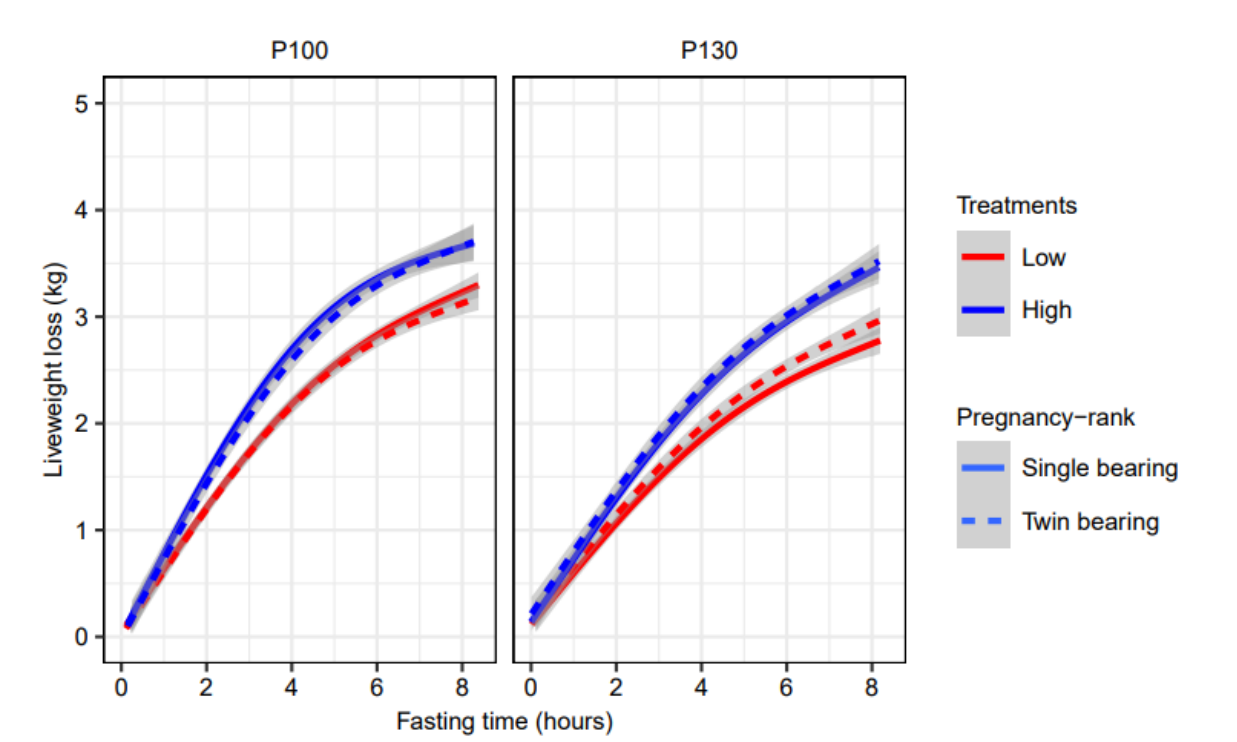
Figure 2. Change in liveweight (with 95% CI, grey shade) of the ewes offered the High herbage level at 100 days (P100) of pregnancy from the midpoint of a 17-day breeding period and 130 (P130) days. Herbage availability (Low target range herbage availability: 900–1100 kg DM/ha; High ≥ 1400 kg DM/ha).